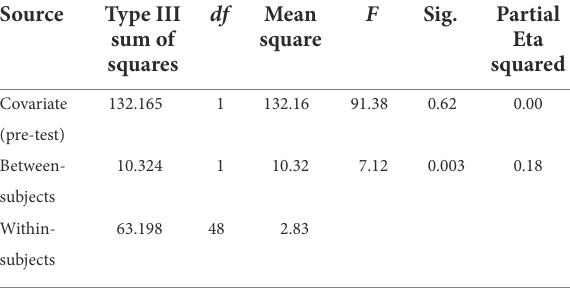
TABLE 5 ANCOVA results, investigating the effect of flipped classroom on the EFL students’ writing anxiety after controlling for the